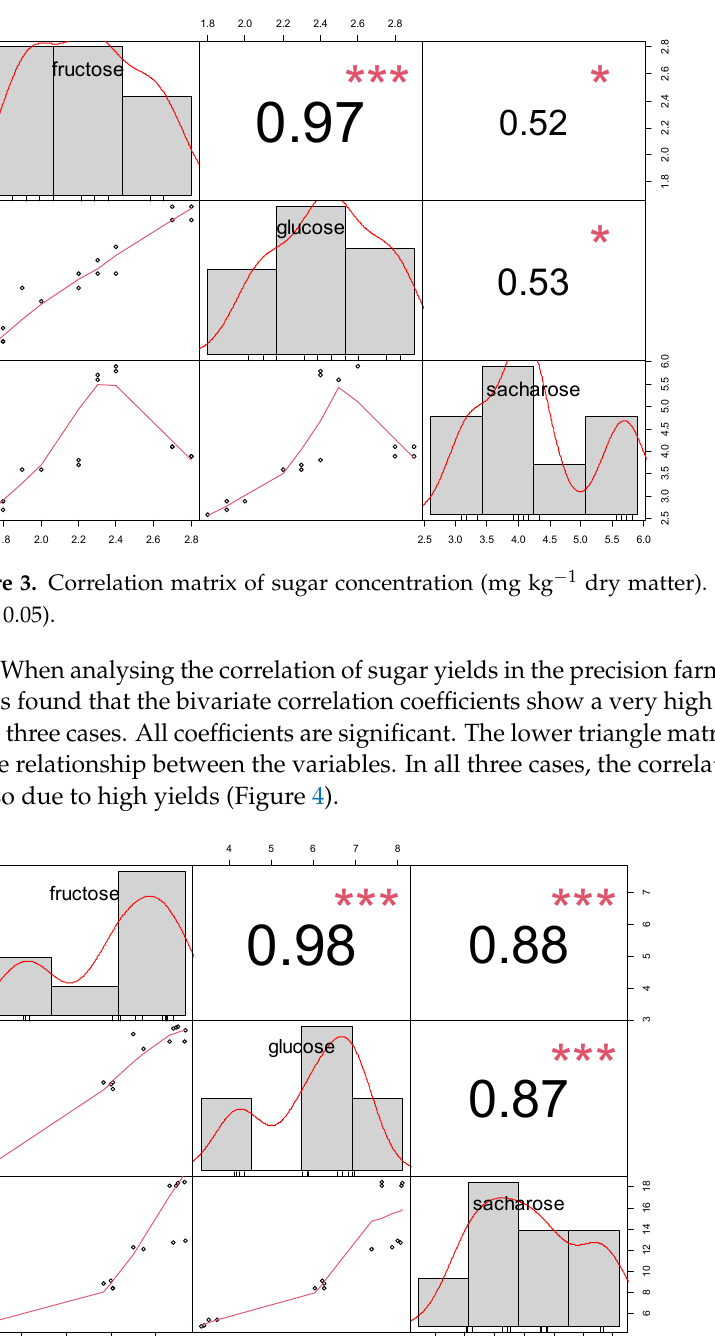
Figure 4. Correlation matrix of sugar yields (mg kg − 1 × yield t ha − 1 ).